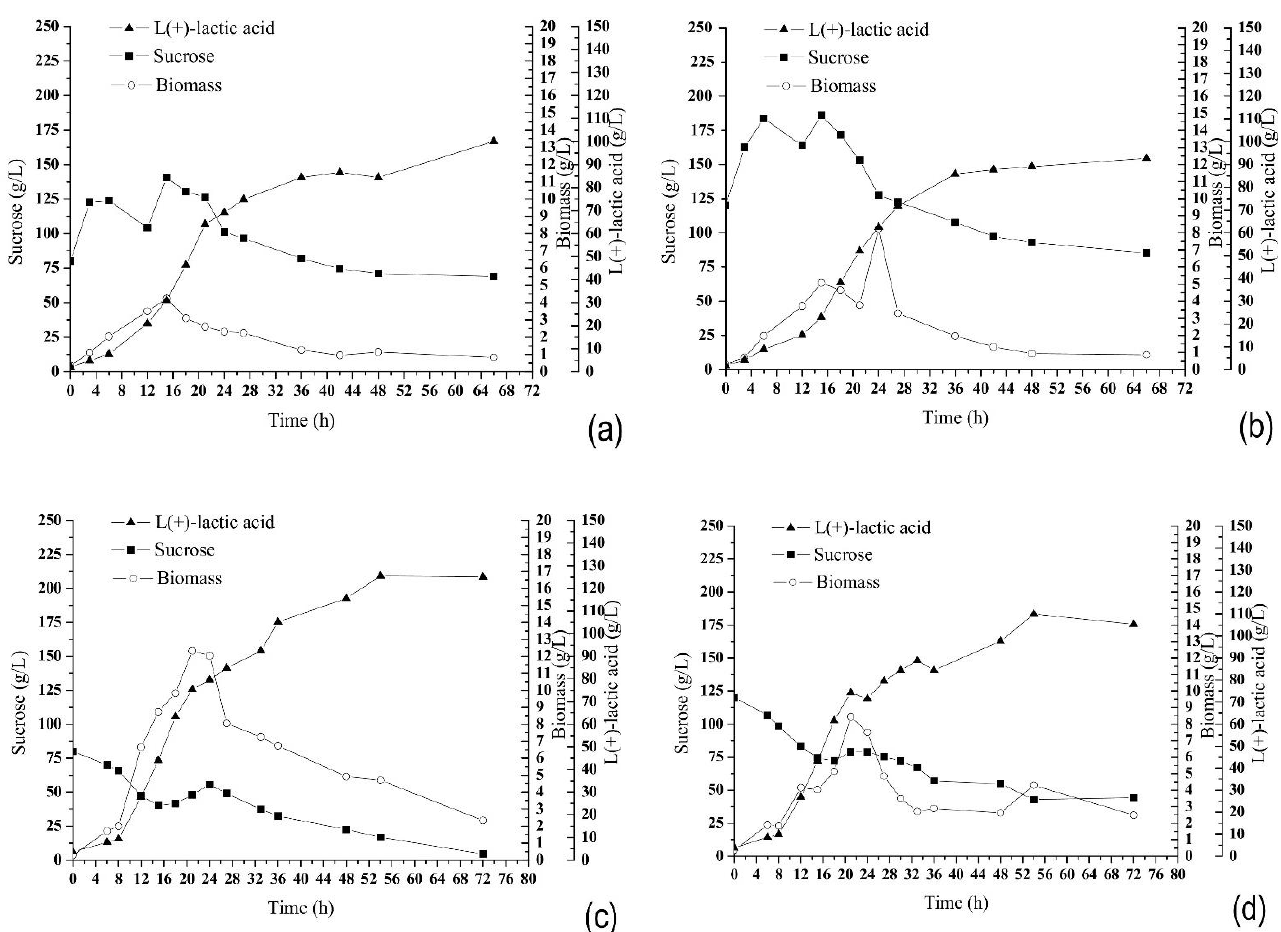
Figure 7. Kinetics of production of L(+)-lactic acid, sucrose consumption and growth of microorganism L. casei Ke11 in 0.5-L reactor with pulse fed batch fermentation with initial sucrose concentration of ( a ) 80 g/L ( b ) and 120 g/L and constant fed batch with initial sucrose concentration of ( c ) 80 g/L ( d ) and 120 g/L.